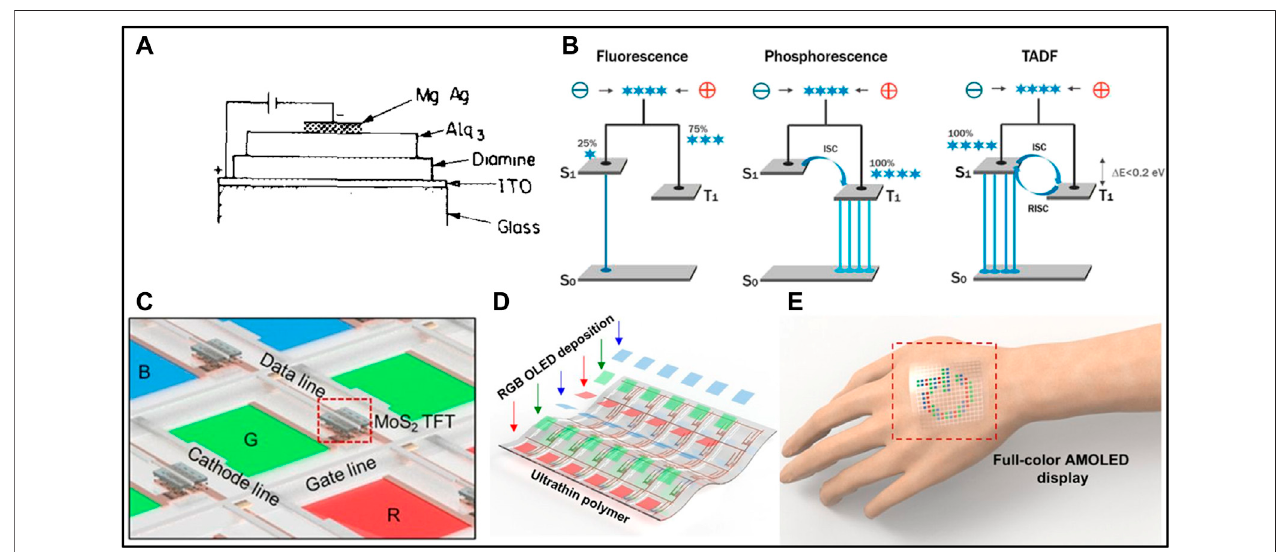
FIGURE 3 | (A) Structure of the fi rst OLED with an Mg/Ag alloy with a molar ratio of 10:1 as the cathode, Alq 3 as the emissive layer, diamine as the hole transport layer, and an ITO-coated glass substrate as the anode (Tang and VanSlyke, 1987). (B) Scheme of mechanism for fl uorescence, phosphorescence, and TADF (Pode, 2020). (C) Schematicdiagram, (D) depositionillustration,and (E) photo offull-color AMOLED fabricated ona6-µmPET thin fi lmand powered bytwo-dimensionalMoS 2 transistors with single-pixel that was connected with the gate line, the cathode line, and a MoS 2 transistor (Choi et al.,